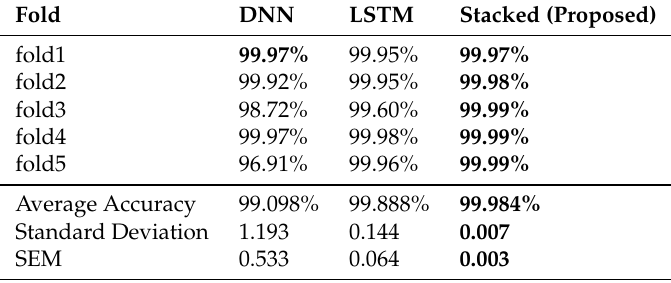
Table 3. Results of classifiers’ performance in terms of 5-fold cross-validation; best results are indicated with